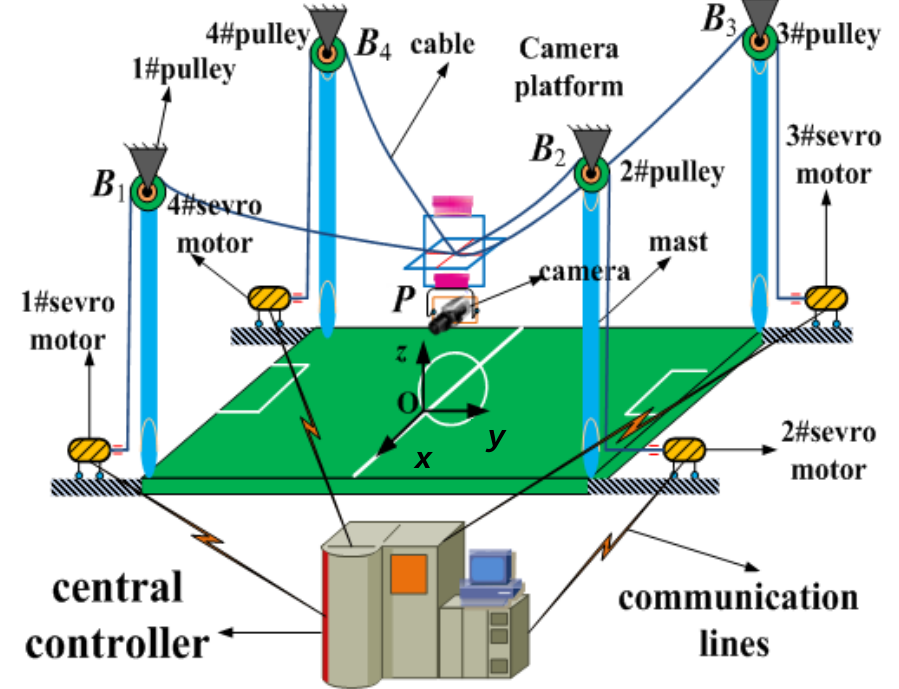
Figure 2. Schematic of a camera robot.